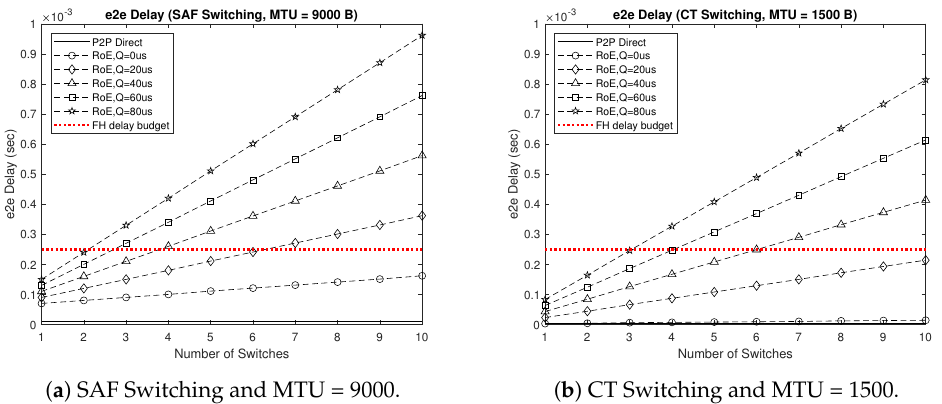
Figure 6. e2e delay results of the proposed 5GB neutral host design architecture for the 100-story- building deployment scenario.